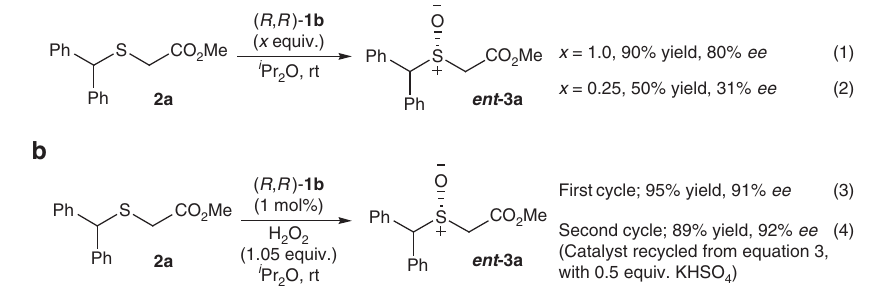
Figure 6 | Mechanistic insights. ( a ) [ BG ] 2 þ [( m -SO 4 )Mo 2 O 2 ( m -O 2 ) 2 (O 2 ) 2 ] 2 (cid:2) ( R , R )- 1b as the sole oxidant. ( b ) 1mol% ( R , R )- 1b as catalyst.